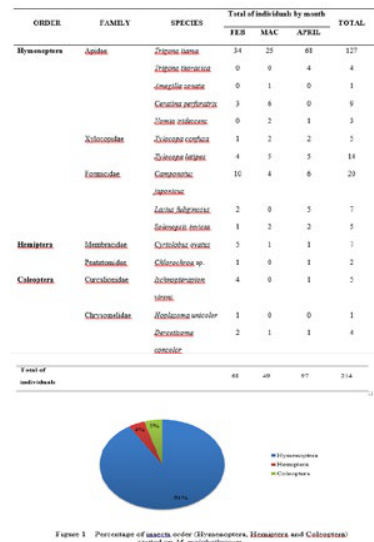
Total of insects collected to visit on Melastoma malabathricum in UKM Bangi Forest Reserve per different